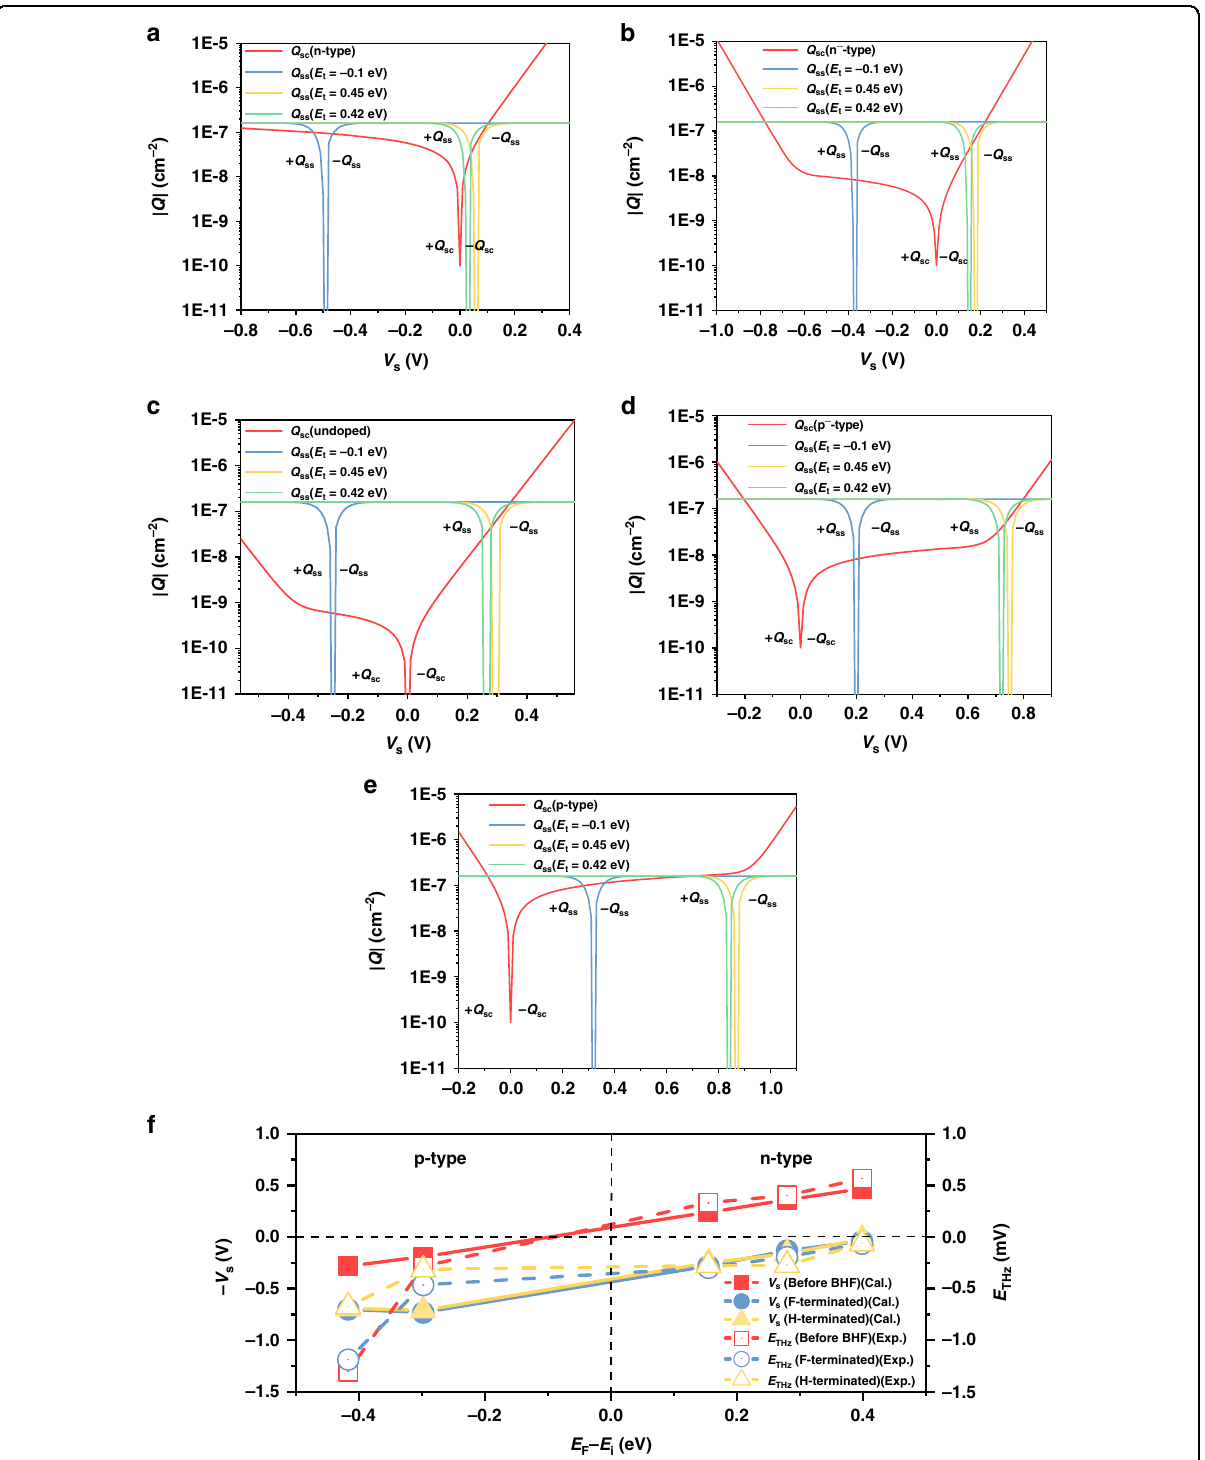
Fig. 6 Surface charge calculation and comparison with THz emission. Calculated Q ss – V s and Q sc – V s curves in different surface state energy-level conditions. ( E t = − 0.1, 0.45, and 0.42 eV): ( a ) n-type Si, ( b ) n − -type Si, ( c ) undoped Si, ( d ) p − -type Si, and ( e ) p-type Si. f Comparison between the calculated surface potential and THz emission amplitude for different treatment conditions:before BHF etching, at the F-terminated surface, and at the H-terminated